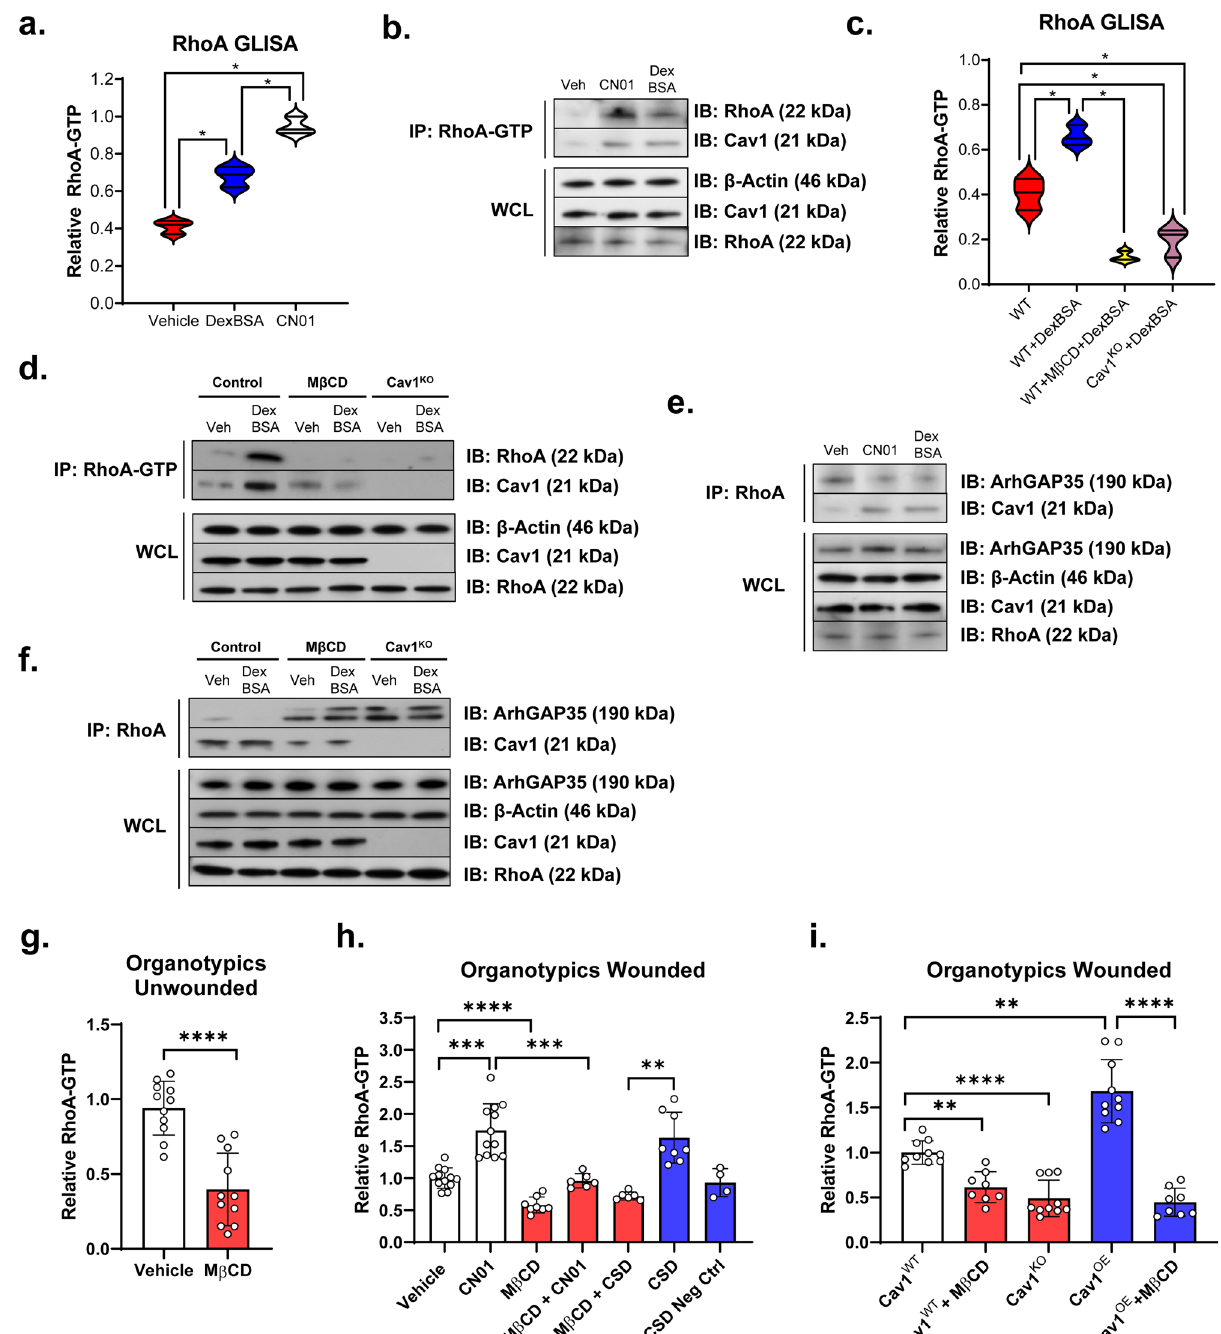
Fig. 3 Glucocorticoids promote stress fi ber induction by increasing RhoA activity in a Cav1-dependent manner. Primary human keratinocytes were treated with either DexBSA or a known RhoA activator CN01 (calpeptin), with RhoA activity measured by GLISA ( a ) and validated by pulldown experiments ( b ). Normal human keratinocyte cell lines and Cav1 KO keratinocytes were treated with DexBSA in presence/absence of M β CD, with RhoA activity measured by GLISA ( c ) and validated by pulldown experiments ( d – f ). Each GLISA experiment was carried out in triplicates from three independent experiments and statistical signi fi cance analyzed using paired Student ’ s t test, * p < 0.05. For pulldown experiments, both GTP- as well as total RhoA antibodies were used. Levels of active RhoA ( b , d ), relative to total RhoA ( e , f ), as well as their interaction with Cav1 and ArhGAP35 were determined by immunoblotting ( f ), with β -Actin serving as loading control. Primary human keratinocytes and fi broblasts were used to construct 3D human skin equivalent organotypics ( g , h ) cultures, which were treated in presence or absence of M β CD and caveolin scaffolding domain (CSD) peptide and subject to RhoA GLISA in order to determine RhoA-GTP status. CN01 served as a positive control for activation of RhoA. i Cav1 WT , Cav1 KO and Cav1 OE keratinocyte cell lines in combination with normal primary human fi broblasts were used to construct 3D human skin equivalent organotypics cultures which were treated in presence or absence of M β CD, wounded and subjected to RhoA GLISA in order to determine RhoA-GTP status. Each GLISA experiment was carried out in triplicates from three independent experiments and statistical signi fi cance analyzed using paired Student ’ s t test, ** p < 0.01, *** p < 0.001, **** p <